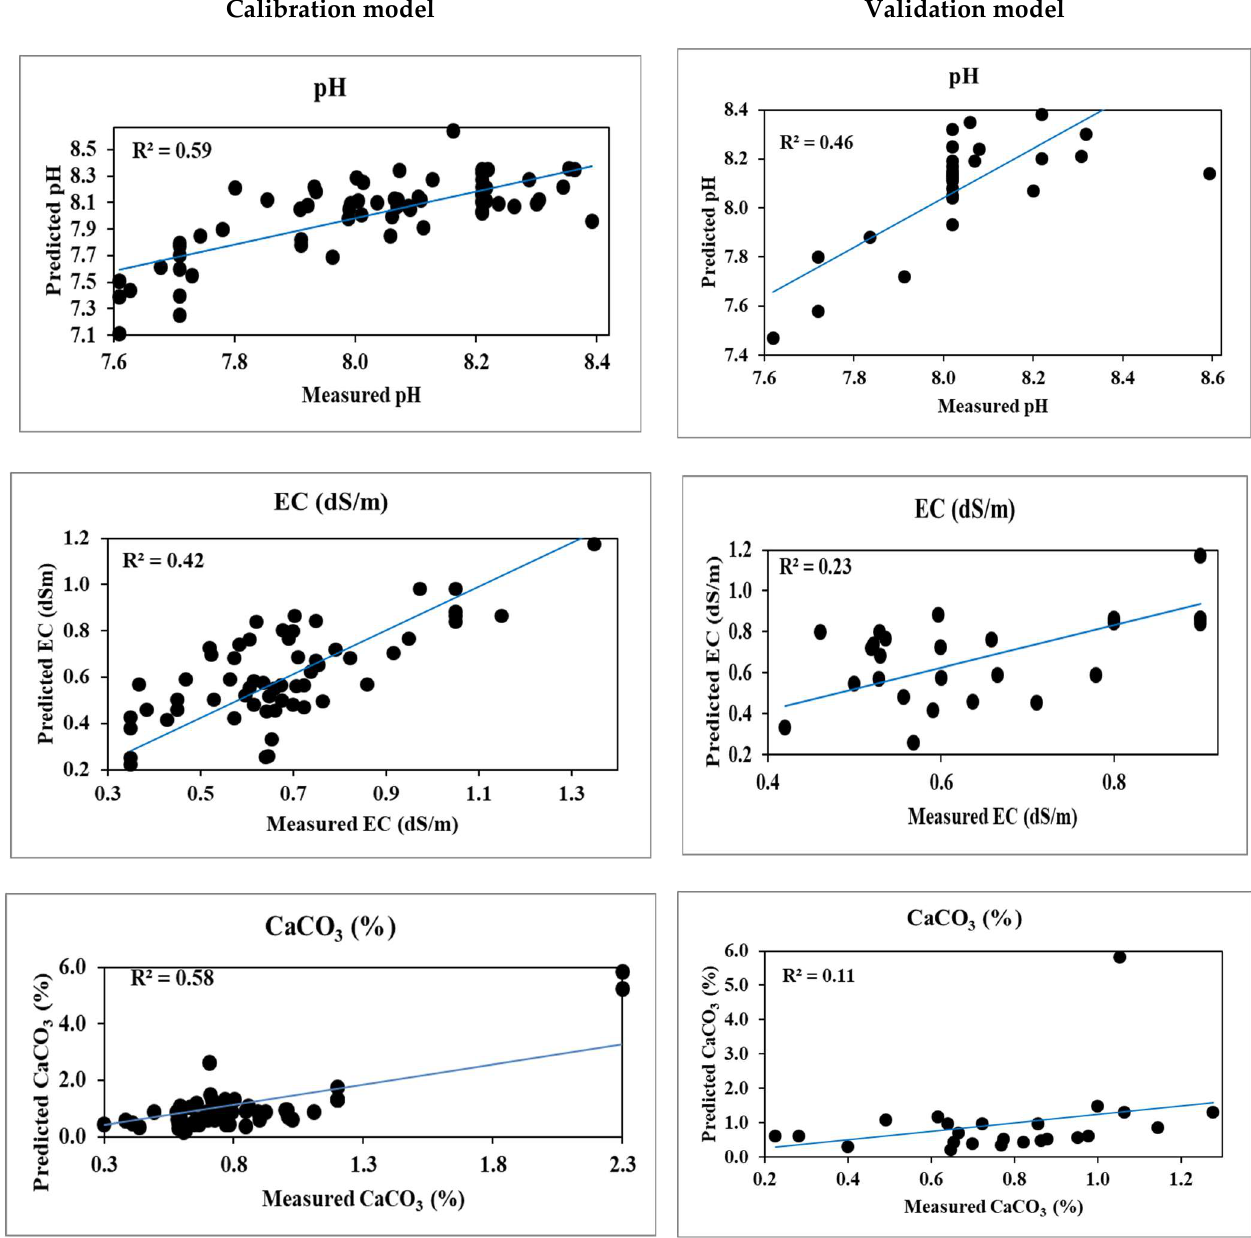
Figure 6. MARS calibration and validation of soil